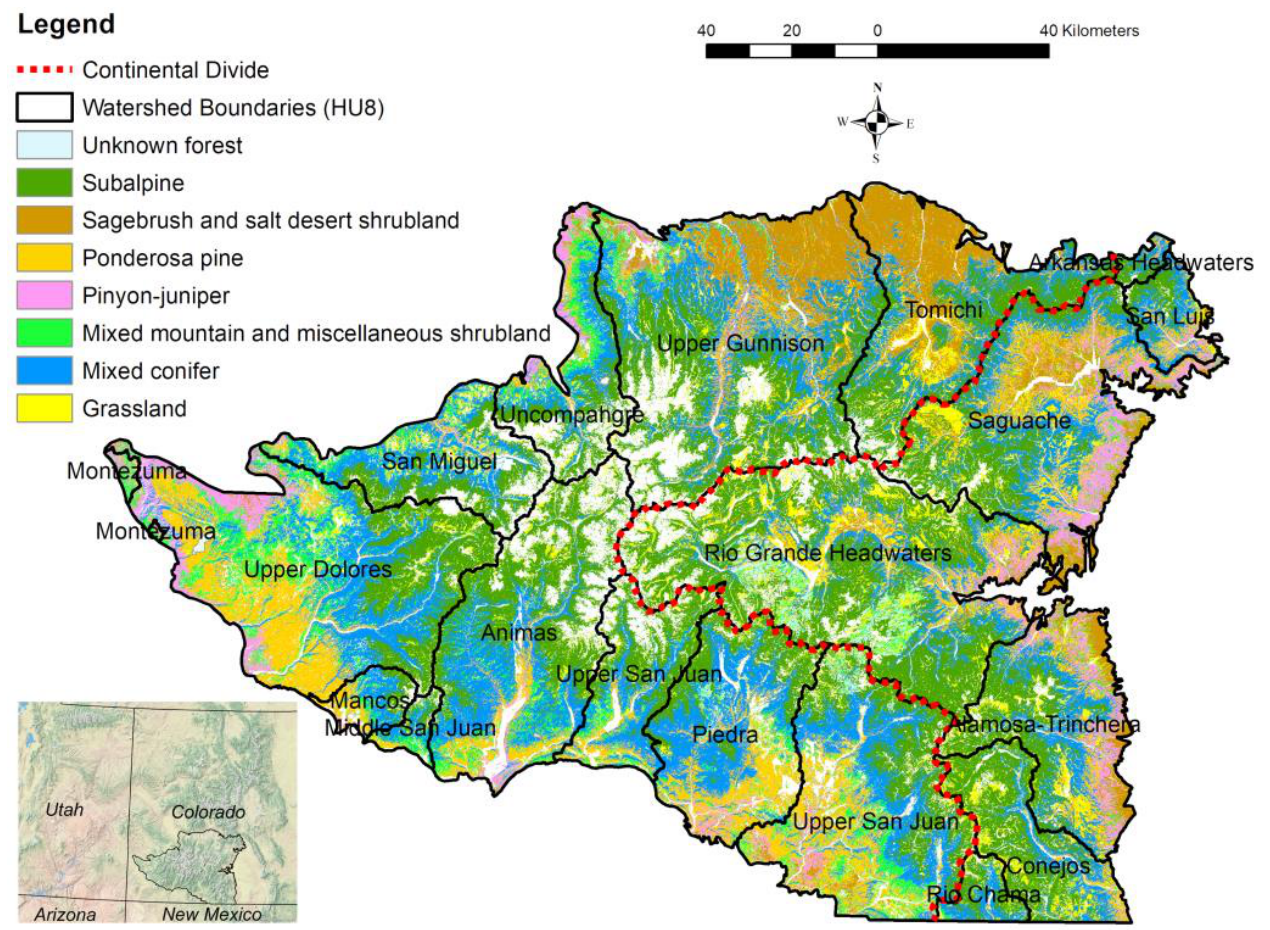
Figure 1. The study area in southwestern Colorado, showing the Continental Divide, the 18 water- sheds, and the eight pooled ecosystem types.